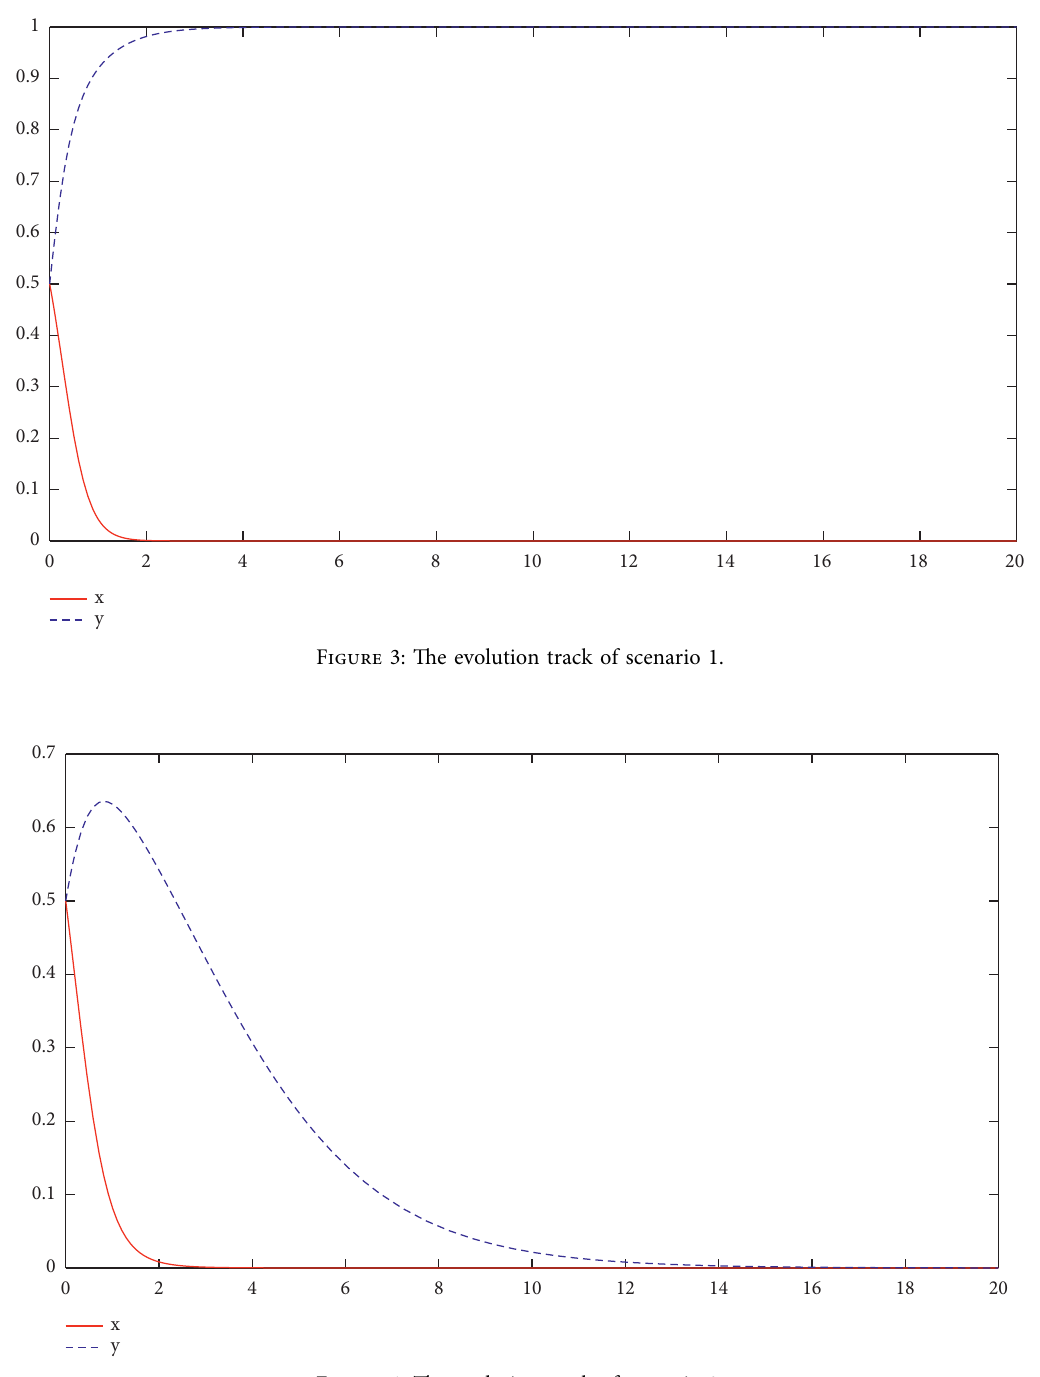
Figure 4: The evolution track of scenario 2.